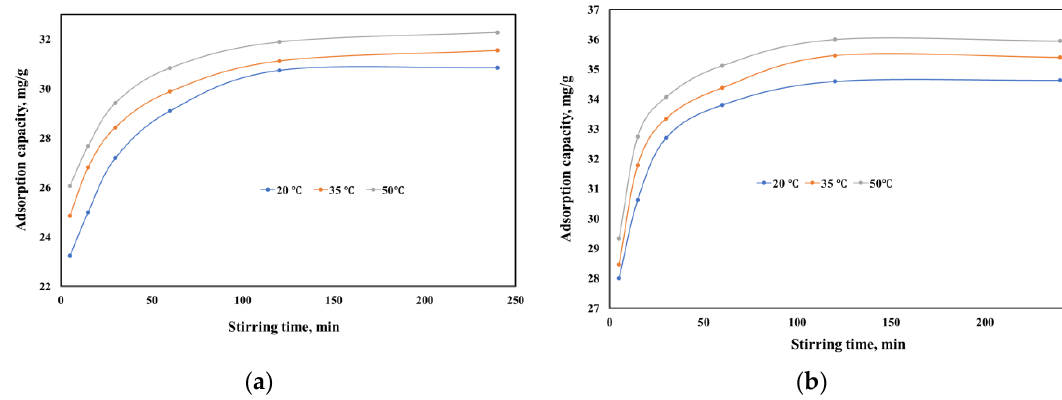
Figure 5. Effect of contact time on the adsorption capacity of ( a ) Mg 4 Fe and ( b ) Mg 4 Fe-450 at three different temperatures in the removal process of MoO 42− from aqueous solutions. S:L = 1 g/L, C 0 = 50 mg/L Mo(VI), pH = 6.